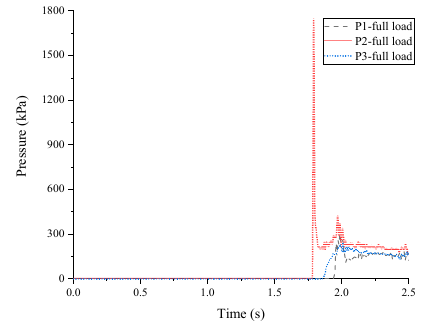
Figure 14. Pressure at P1, P2 and P3 in the case of full load.